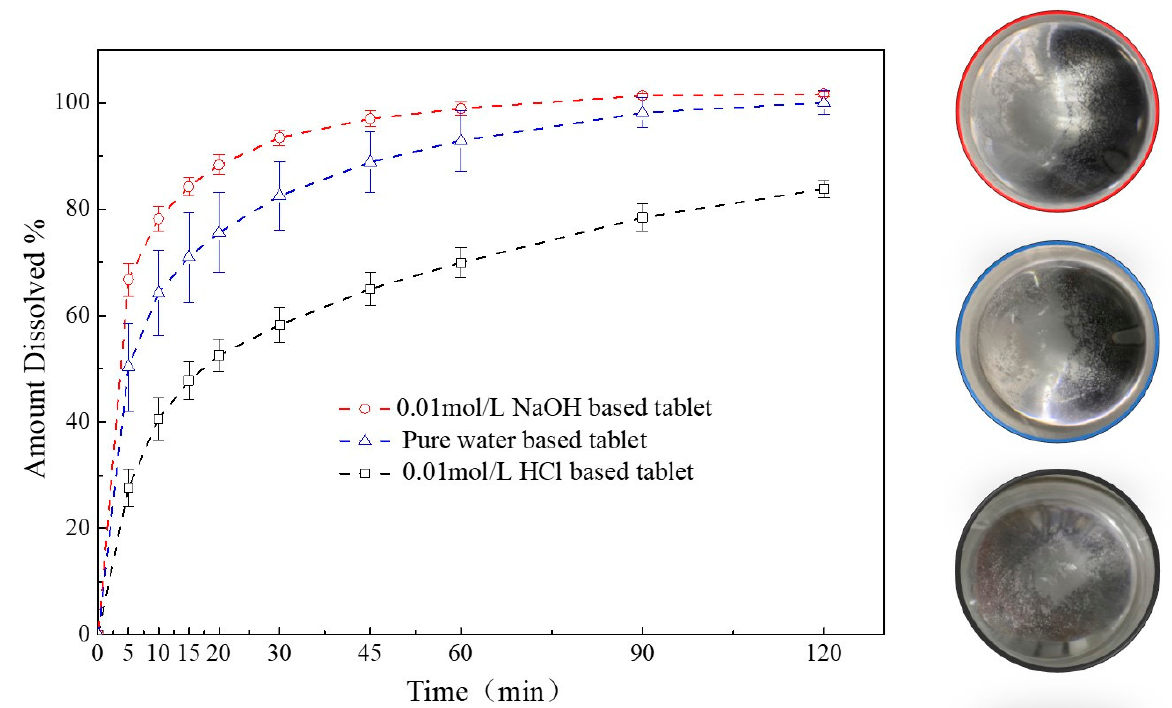
Figure 11. Comparison of dissolution profiles of different media ‐ based granule formulated tablets.